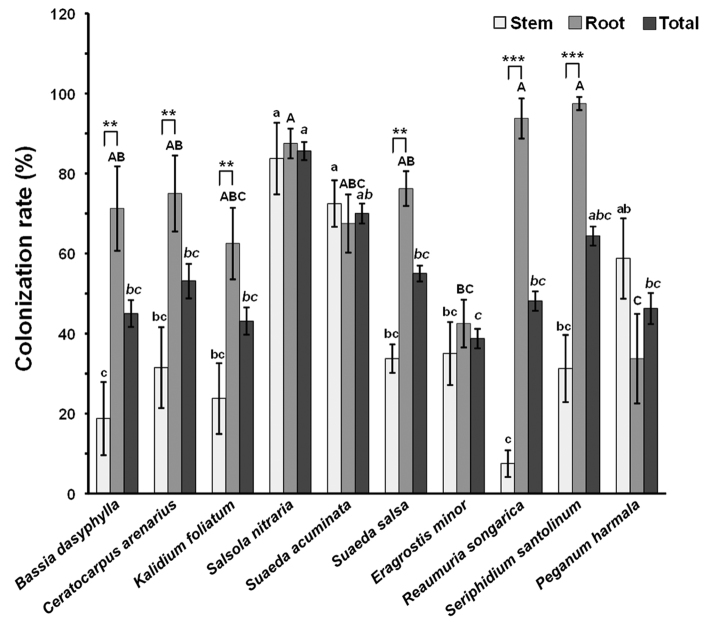
Colonization rate of endophytic fungi in stem, root, and total (stem + root) tissues of the ten halophyte species. Data are means ± SE (n = 10). Columns without shared lowercase, uppercase, and italic letters denote the significant difference in the stem, root, and total tissues among the halophyte species, respectively. Asterisks above bars indicate significant difference between stem and root tissues for each plant species (** P < 0.01, *** P < 0.001).